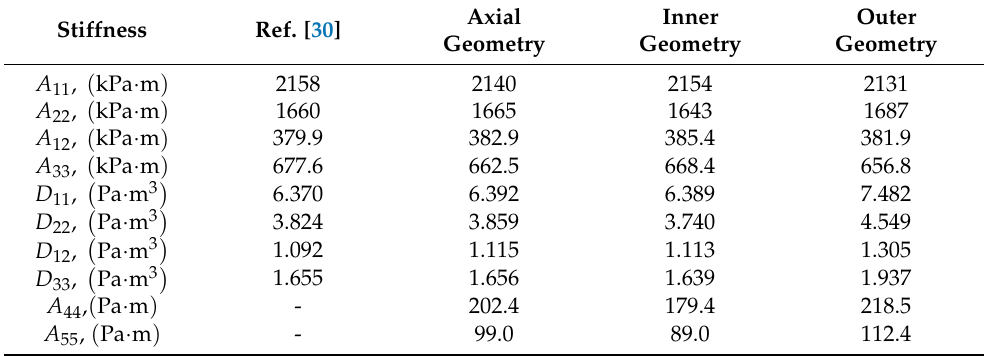
Table 2. The stiffnesses of representative shell element computed for a different approach of mod- elling confronted with data from ref. [30] for saw tooth geometry.